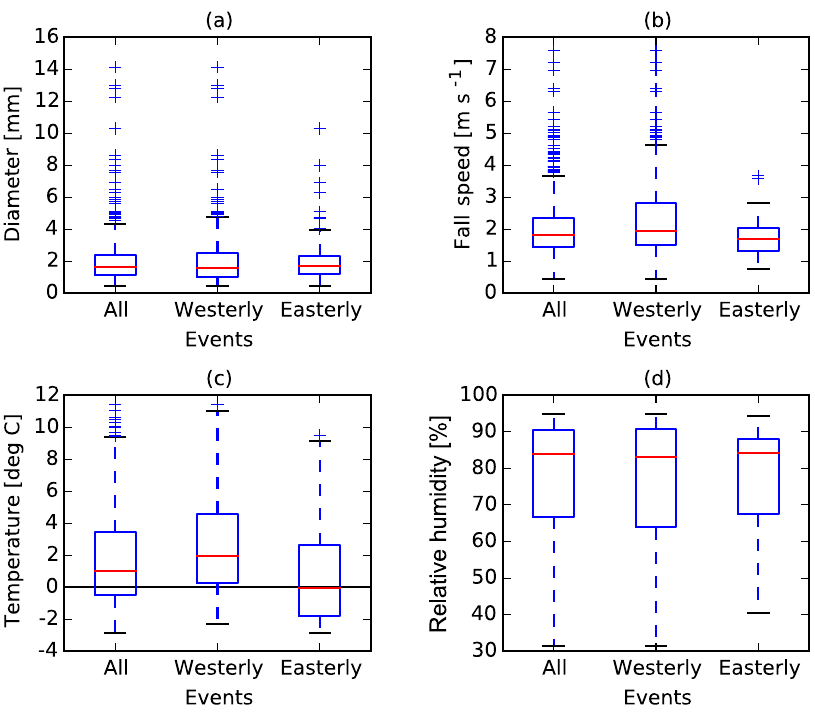
Figure 9. Summary over the March–April 2015 period of the (a) diameter, (b) fall speed, (c) temperature and (d) relative humidity represented by a box plots. The red line is the median, the box is between the 25th and 75th percentiles, and the whiskers are the 5th and 95th